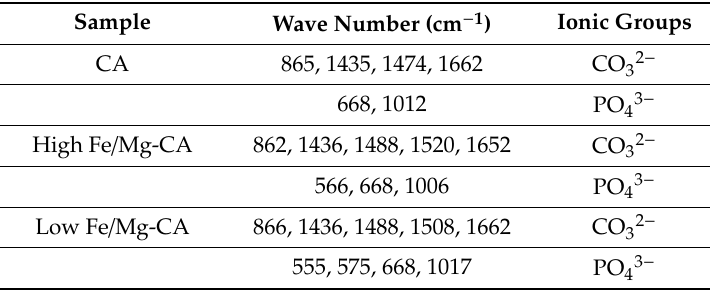
Table 2. Fourier transform infrared spectroscopy (FTIR) profile for CA (carbonate apatite), and low Fe / Mg-CA (low Fe / Mg-carbonate apatite) and high Fe / Mg-CA NPs (high Fe / Mg-carbonate